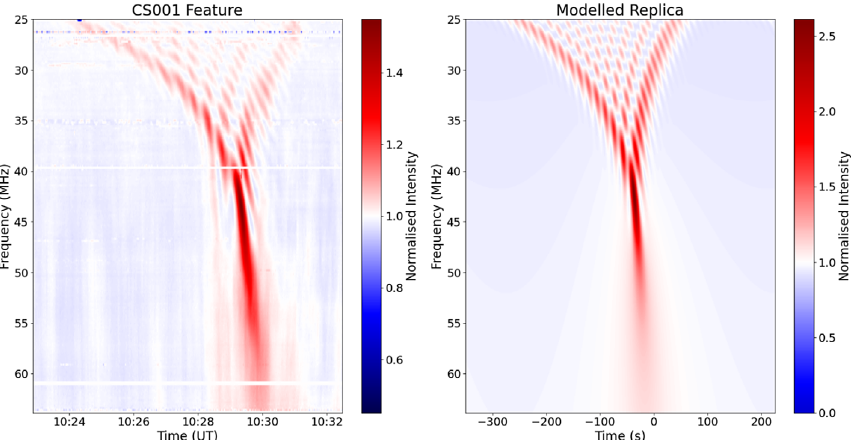
Fig. 6. The feature observed in the dynamic spectrum of Cygnus A by one of the stations in The Netherlands (station CS001: 52.9 (cid:3) N, 6.9 (cid:3) E), alongside the modelled replica (note that different colour scales are used in each panel). As in Figure 4, the time scale of both panels is the same, with t = 0 corresponding to the minimum of electron density (i.e. the maximum of phase change) lying on the line of sight. The parameters used here are: U 0 = 8 (cid:2) 10 8 rad Hz, K = 25 km, h = 8.8 (cid:3) and a = 7.58 (cid:2) 10 4 rad Hz m (cid:3) 1